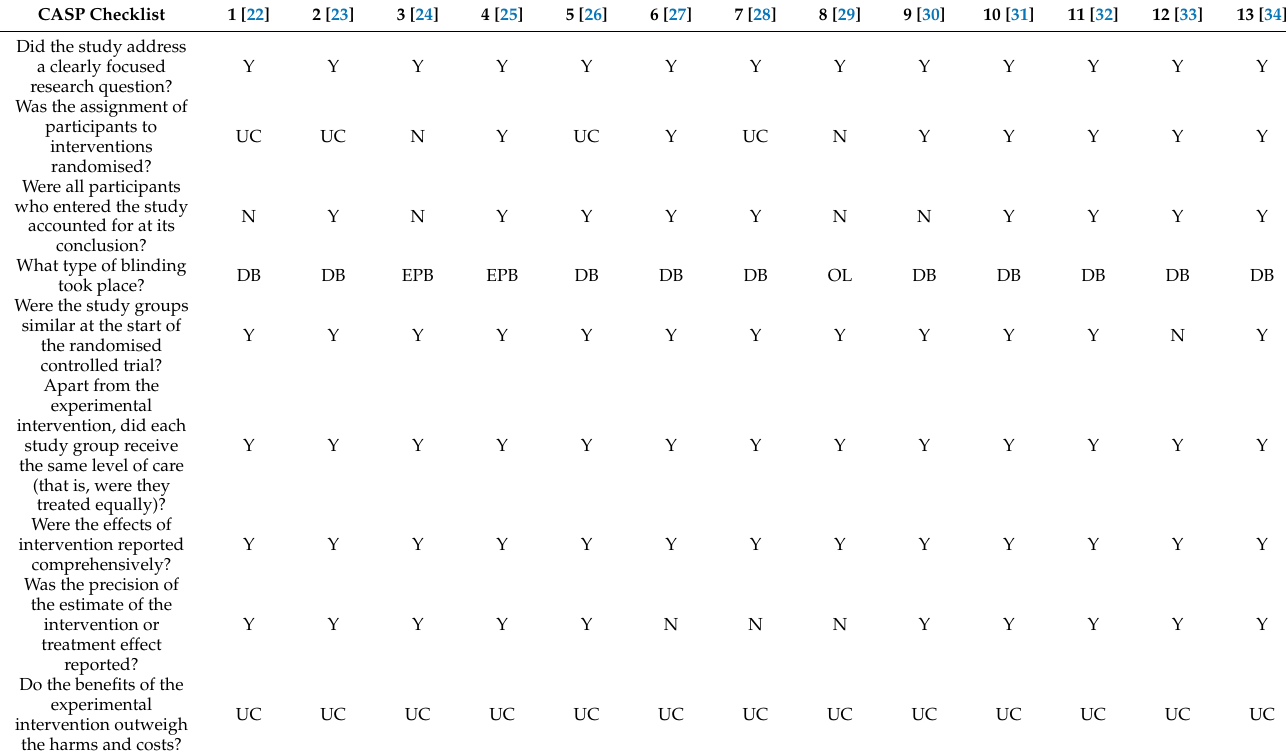
Table 6. The results of the CASP tool [20], which are used to guide the reviewers to answer specific questions about the study design in order to determine the quality of the